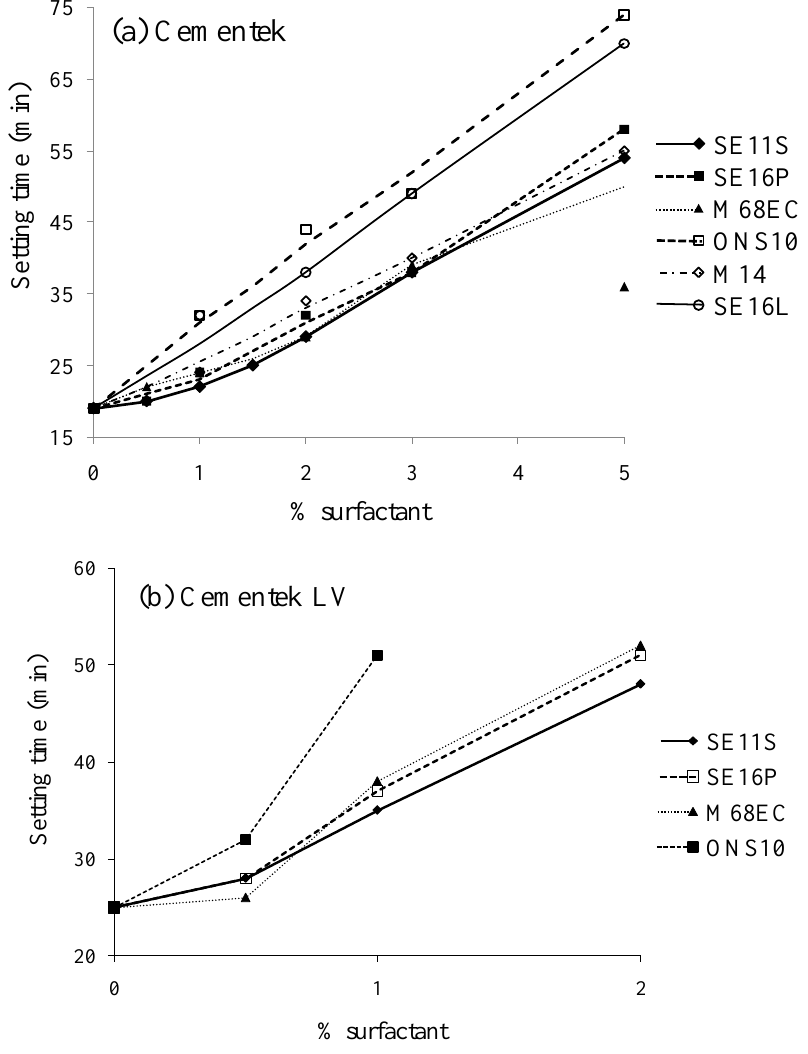
Figure 1. Setting time (min) (cement + surfactant sterilized after mixing). ( a ) Cementek; ( b ) Cementek